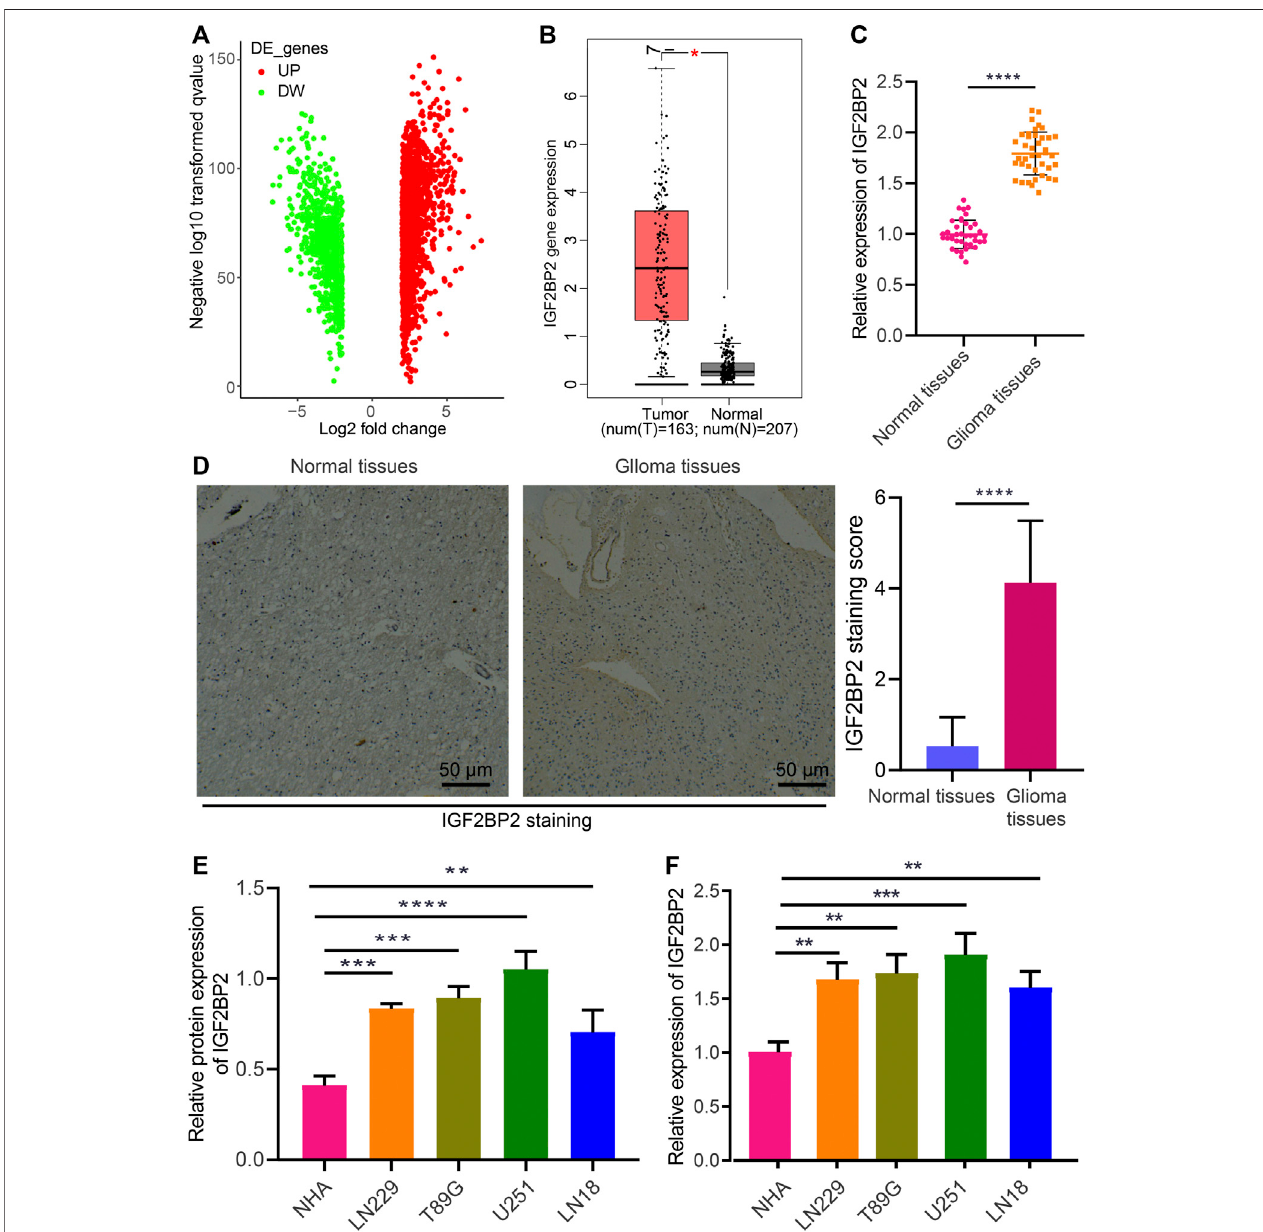
FIGURE1| AberrantexpressionofIGF2BP2ingliomacellsandtissues. (A) Volcanoplotofdifferentiallyexpressedgenesingliomasamplesandnormalsamplesin theTCGAdatabase.DE,differentiallyexpressedgenes;UP,upregulated;DW,downregulated. (B) ExpressionofIGF2BP2ingliomasamplesintheTCGAdatabase. (C) RT-qPCRanalysisofIGF2BP2mRNAexpressioningliomatissuesandnormalbraintissues. (D) ImmunohistochemistryofIGF2BP2proteiningliomatissuesandnormal braintissues. (E) WesternblotanalysisofIGF2BP2proteininGBMcelllines(U251MG,LN229,LN18,T98G)andtheprimarynormalhumanastrocyteNHAcellline. (F) RT-qPCRanalysisofIGF2BP2mRNAexpressioninGBMcelllines(U251MG,LN229,LN18,T98G)andtheprimarynormalhumanastrocyteNHAcellline.* p < 0.05, ** p < 0.01, *** p < 0.001,**** p < 0.0001.Values shown represent mean ± standarddeviationofthreeindependently performedexperiments. Databetween